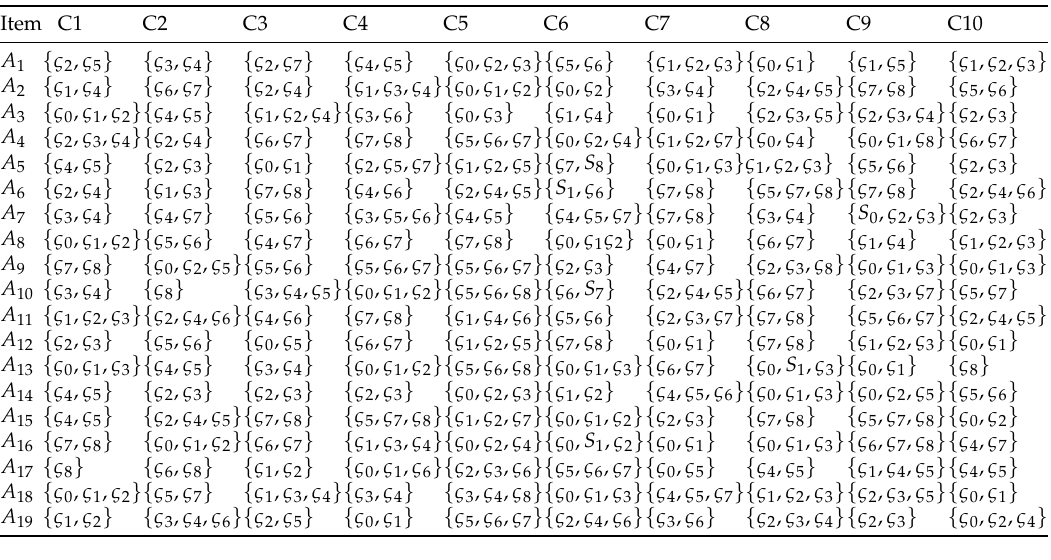
Table 3. Decision matrix Y 2 with respect to decision makers 4, 5, and 6.